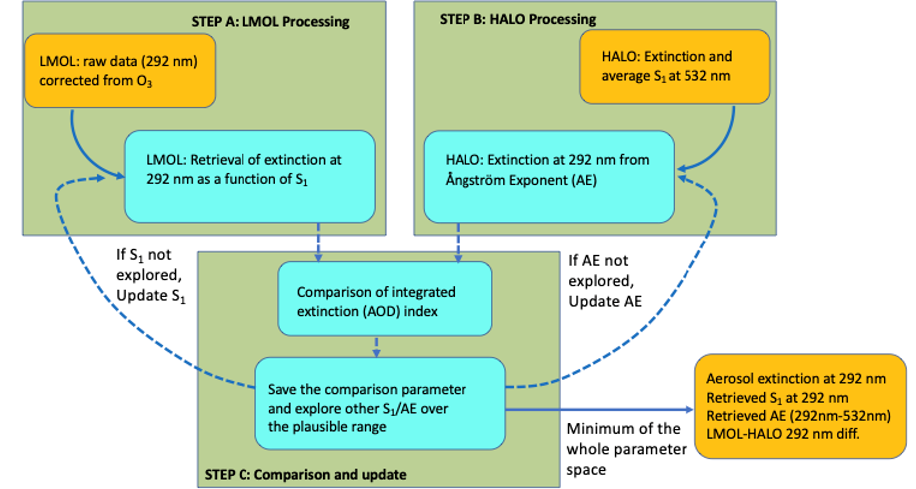
Figure 1. Flow chart of the approach used in this work. The cyan section corresponds to the processing needed for the retrieval of the optimal (S 1 , AE)